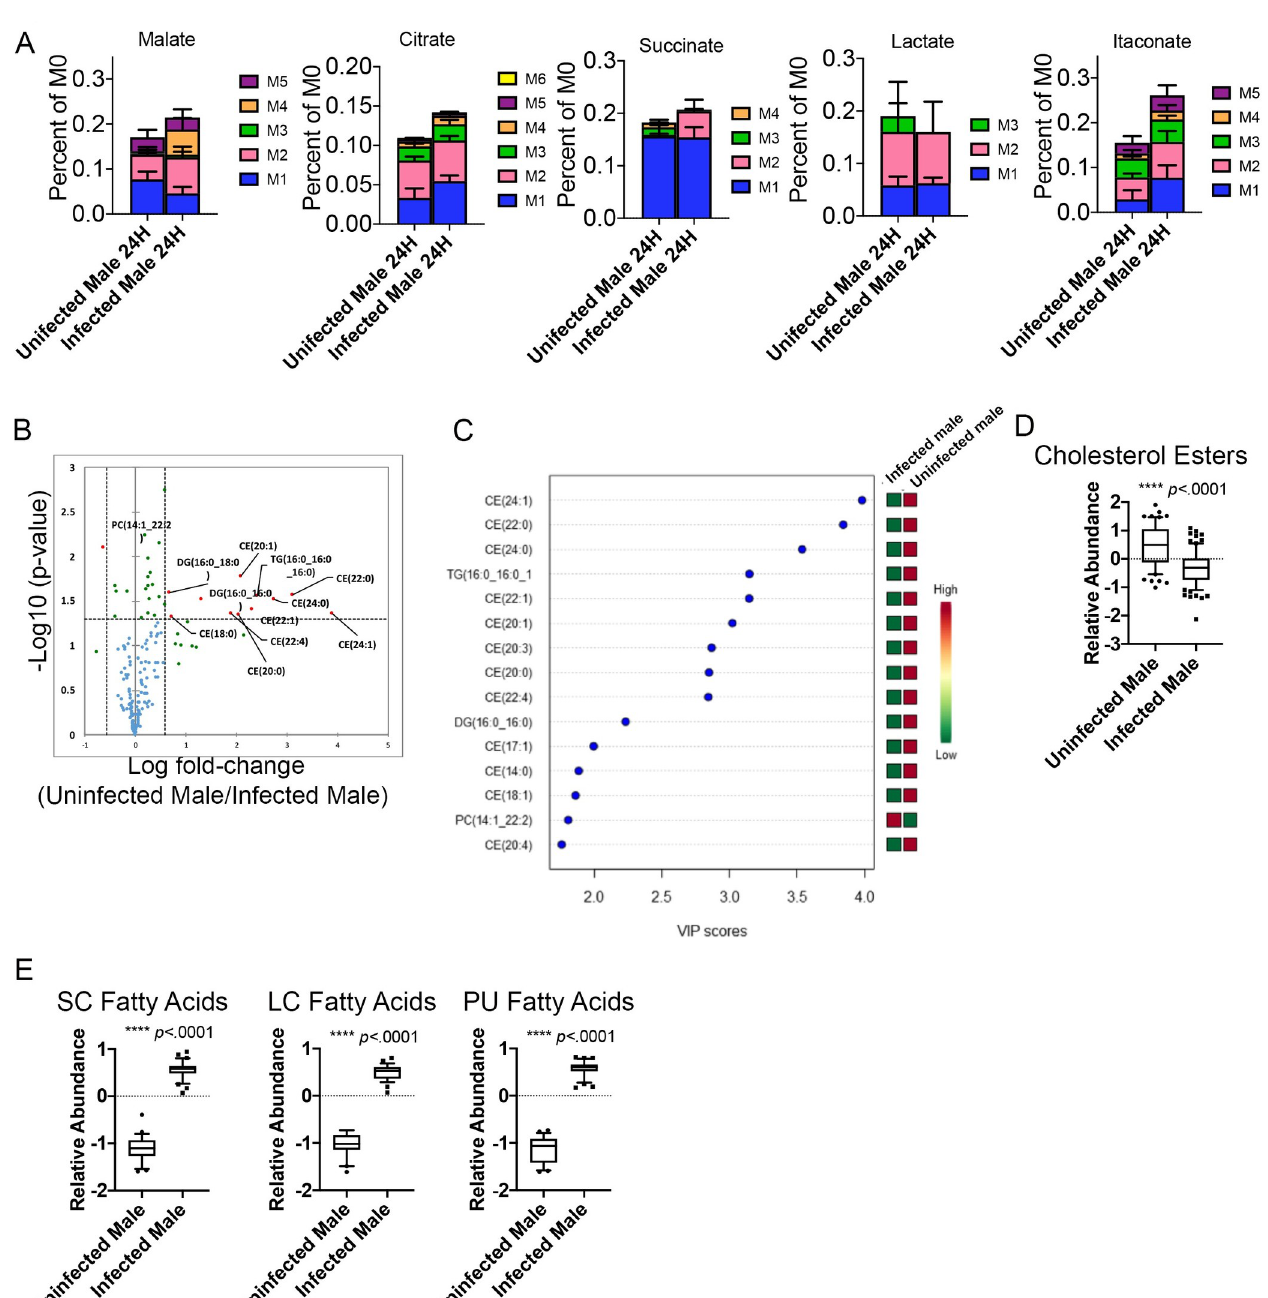
Fig 2. BMDM from male S . mansoni infected HFD ApoE -/- mice have increased TCA cycle usage with significantly increases free fatty acids and reduced cholesterol esters. A-E) M ϕ were differentiated from bone marrow of 10-week infected animals with M-CSF in a 7-day culture in normal glucose and then switched to 13 C-labeled glucose for 24 hours. F-I) M ϕ s were differentiated with M-CSF in a 7-day culture and then total cellular lipids were extracted and analyzed via LC-MS based lipidomic analysis. B) Volcano plot of significantly altered species in uninfected: infected male BMDM C) The variable importance in projections (VIP) scores from uninfected males in comparison to infected males D-E) Box whiskers plots (10–90 percentile) of relative abundance of normalized cholesterol ester and the indicated free fatty acid species, data are normalized to sum and treated with pareto scaling, each dot is a single species. Data are representative of 3 experiments with 4–6 mice per group in each